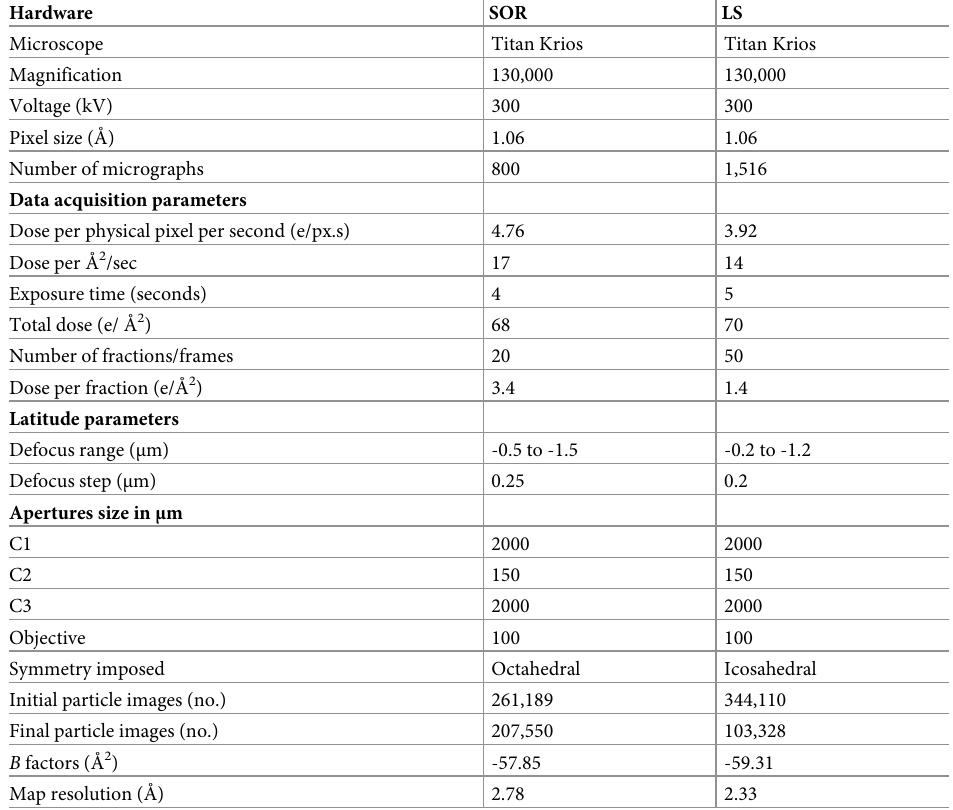
arranged in octahedral symmetry is depicted in Fig 2A . The ribbon diagram of the atomic model viewed from the 4-fold symmetry axis shows four identical subunits ( Fig 2B ). The superposition of the monomeric subunit of the cryo-EM atomic model coincides with the x- ray crystal structure (2CB2) ( Fig 2C ). The average root mean square deviation (RMSD) between the cryoEM and x-ray crystal structures of SOR is 0.575 Å for the 307 C α atoms. Both active site and side chains look very similar between the two structures. The reconstruction of the atomic model (7X9W) into the cryo-EM map and real space refinement were performed in PHENIX [60]. The model building and refinement statistics are shown in Table 2 . Representa- tive secondary structural elements fitted within the respective regions of the cryo-EM map are depicted in Fig 2D . Structure of the catalytic site of SOR. In the oxygen-dependent sulfur disproportion- ation reaction, SOR catalyzes the oxidation and the reduction of elemental sulfur to produce sulfite, thiosulfate, and sulfide ( Eq 1 ) [23, 28, 29]. The core structure of the monomer is each of the 24 monomeric subunits contains a mononuclear non-heme iron site [32], where the Fe 3+ ion is responsible for the positive charge of the inner surface of the hollow cavity in SOR ( Fig 3A ). The density of the side chains of H86, H90 and E114 surrounding the iron center, and that of two water molecules ligated to the Fe 3+ ion are distinguishable in our cryo-EM map ( Fig 3A ). The distances between Fe 3+ ion and the three nearby side chains are denoted and a 180˚ view of the same region is shown. Biochemical studies revealed that